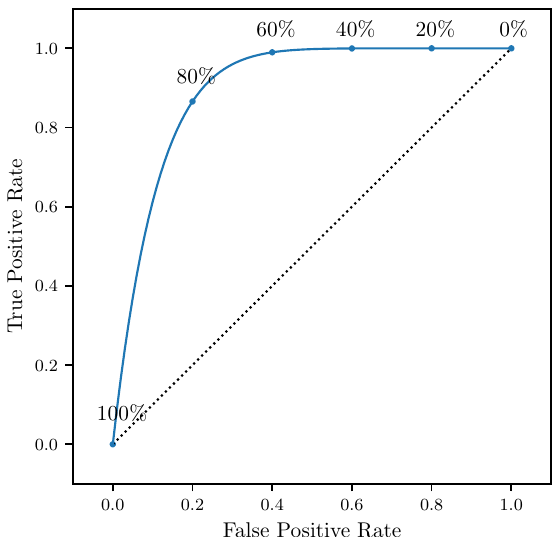
Figure 12. Schematic of an idealized receiver operating characteristic (ROC) curve and with threshold percentiles.